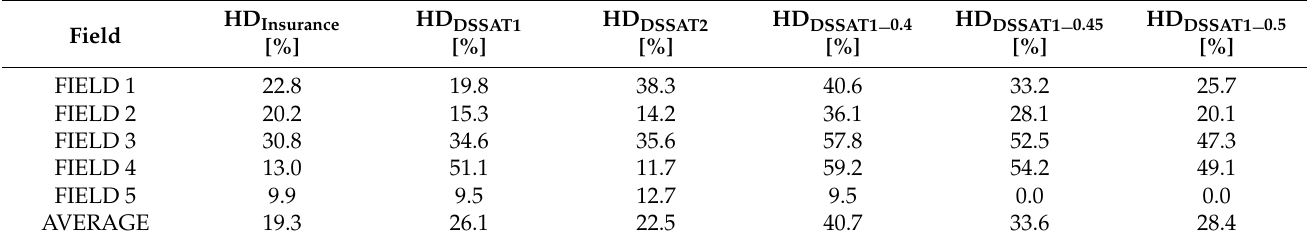
Table 3. Percentage hail damage estimates calculated for the different methodologies.